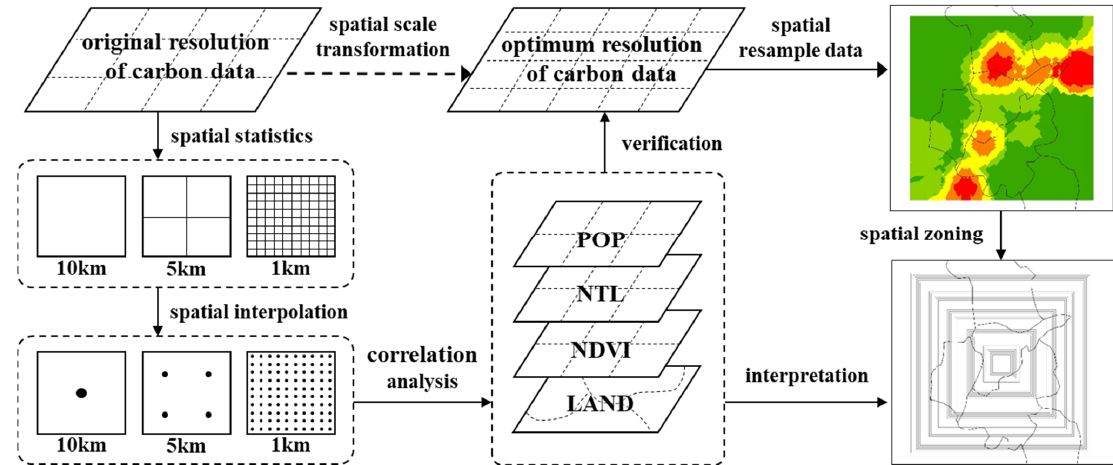
Figure 2. Analytical framework of the study.